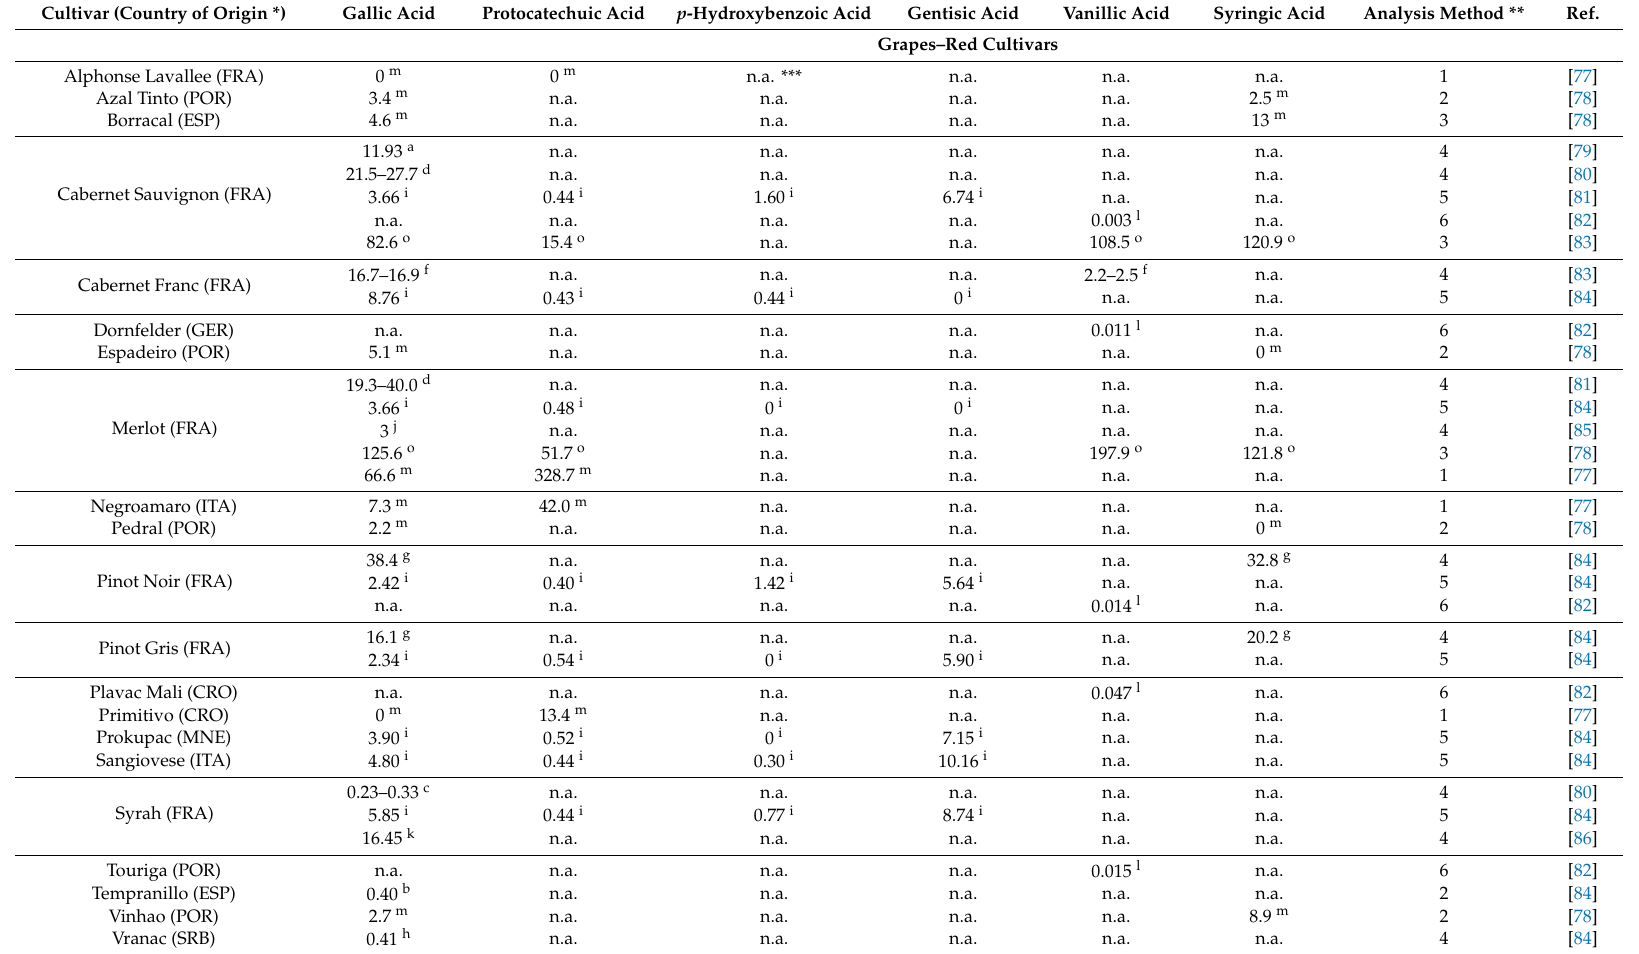
Table 1. Content of hydroxybenzoic acid in the grapes and leaves of di ff erent grapevine